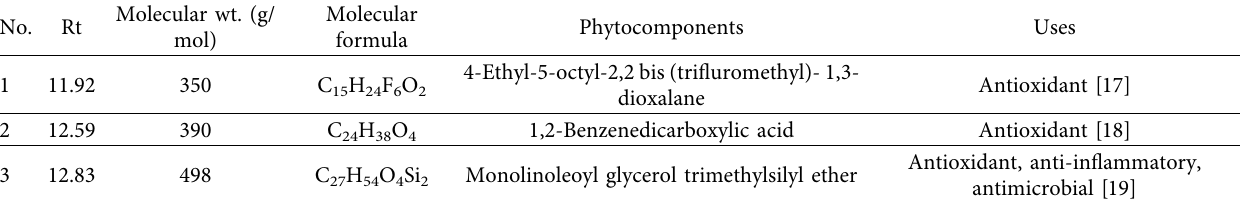
Table 6: GC-MS Analysis of methanol extract of Anagallis arvensis .